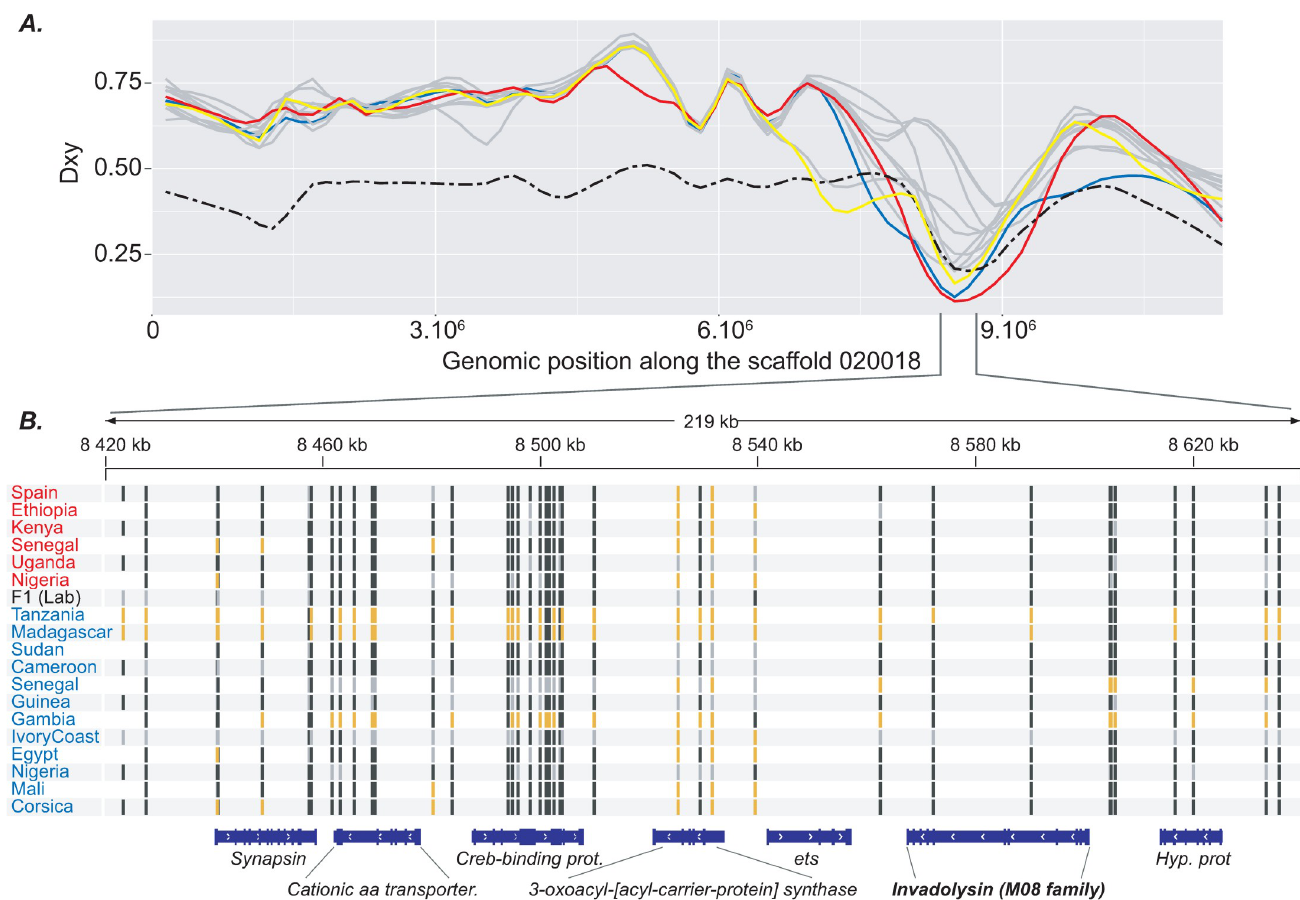
Fig 4. Focus on a S . bovis -like genomic tract detected in some S . haematobium isolates along the genomic scaffold 020018. A. Dxy values computed between each of the 12 S . haematobium isolates and the experimental F1 hybrid and all of the S . bovis isolates along the genomic scaffold 020018. Extremely low values of Dxy were found between three S . haematobium isolates (i.e. Corsica, Mali and Egypt) and S . bovis according to the Dxy = 0.102 fixed threshold (see material and methods). Dxy values corresponding to the isolates from Corsica, Mali and Egypt are in blue, red and yellow respectively. Dxy values computed between the experimental F1 hybrid and all S . bovis isolates are represented by a dashed black line. Dxy values computed between all other isolates and S . bovis isolates are in grey. B. Representation of the allelic state of each isolate at each SNP along the 212.351 bp S . bovis -like genomic tract detected in the isolates from Corsica, Mali and Egypt that contain, among other genes, the Invadolysin gene previously identified in a S . haematobium population from Niger and in a S . haematobium reference strain (Egyptian strain) [41]. SNPs at which isolates are homozygous and harboring an allele identical or different to the genome of reference (Egyptian strain) [41] are in black and orange respectively. SNPs at which isolates are heterozygous are in grey.